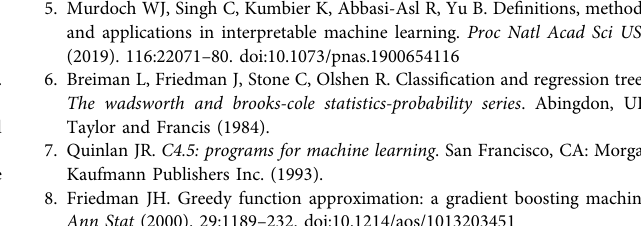
Frontiers in Applied Mathematics and Statistics |